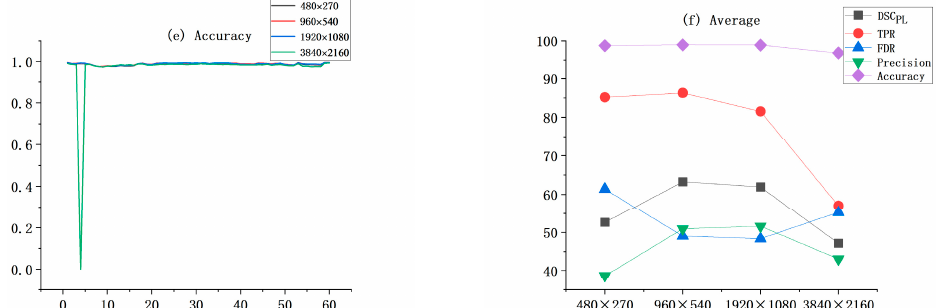
Figure 10. The trend of each performance parameter of Mask RCNN in the test dataset with different chunk sizes. ( a – e ) is the trend plots of the performance parameters (DSCPL, TPR, FDR, Precision, and Accuracy) at each size over 60 images, respectively, and ( f ) is the trend plot of the mean values of these five parameters at different sizes.